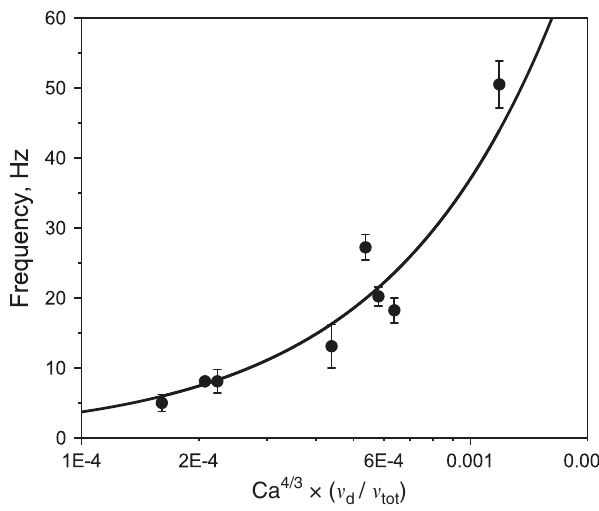
Fig. 2 Droplet frequency characterization. The black circles represent experimentally determined data by varying Q oil and Q aq while maintaining a constant channel geometry. The curve is a fi t of the data where K = 3.7 ± 0.2 m/s and the error bars represent the standard deviation. For each data point, 60 – 80 droplets were analyzed. Source data are provided as a source data fi le.